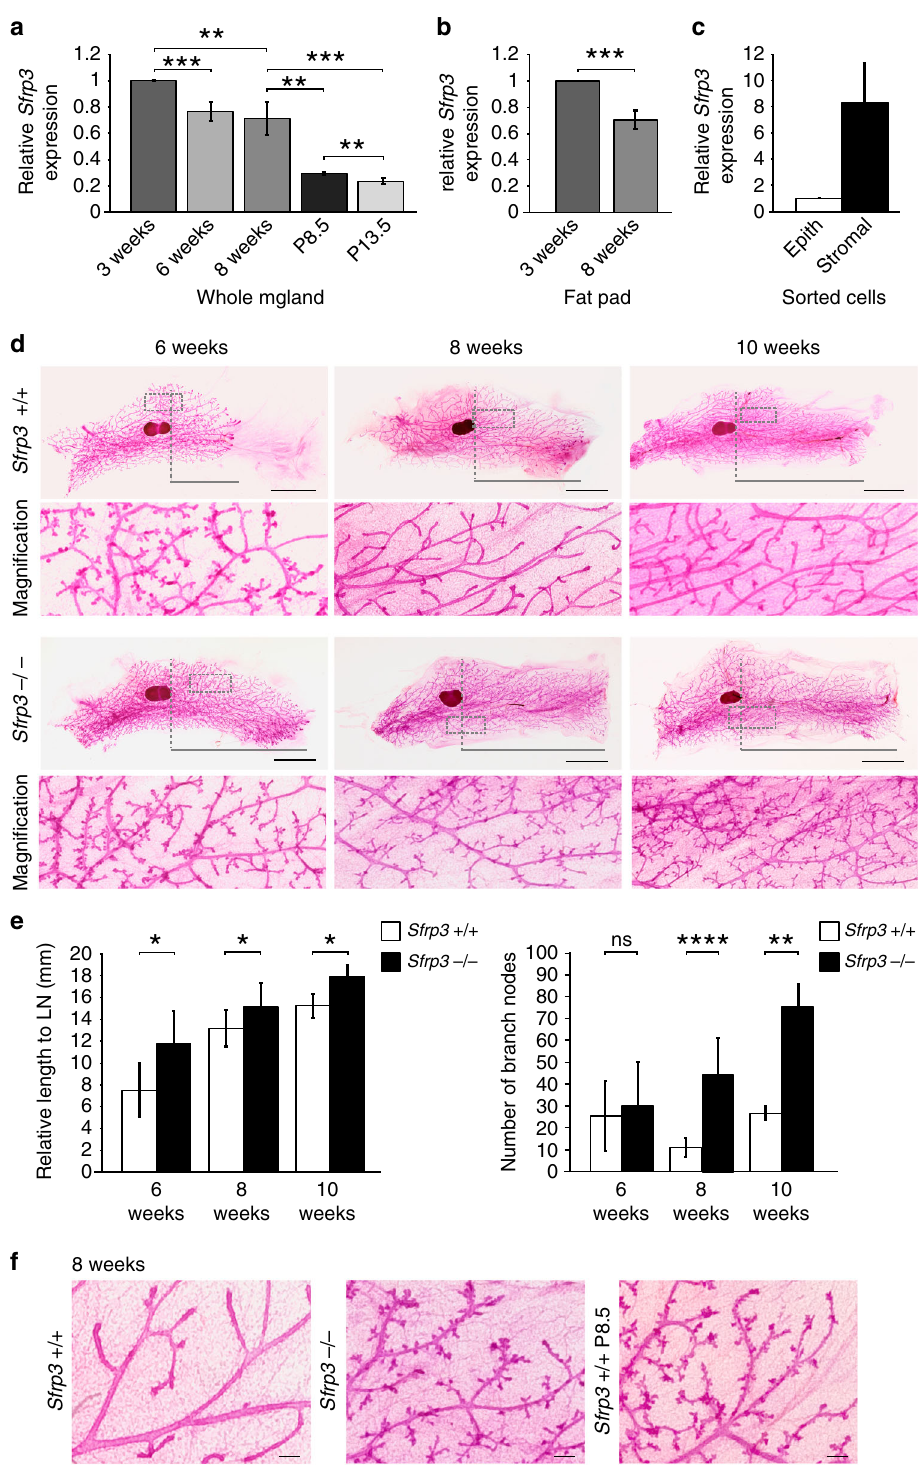
structure of the luminal compartment, while the basal compart- ment is normal (Fig. 2c). The inner luminal epithelium of Sfrp3 − / − ducts is abnormally organised into multiple layers, fi ll- ing in the luminal space of ducts and branches, compared to the single inner layer of luminal cells of the controls (Fig. 2c, d). Next, we analysed the distribution of polarity markers. In wild-type ducts, E-cadherin and ZO1 are localised at adherens and tight junctions, respectively, of luminal cells (Fig. 2e). In Sfrp3 − / − ducts only the most apically localised luminal cells express